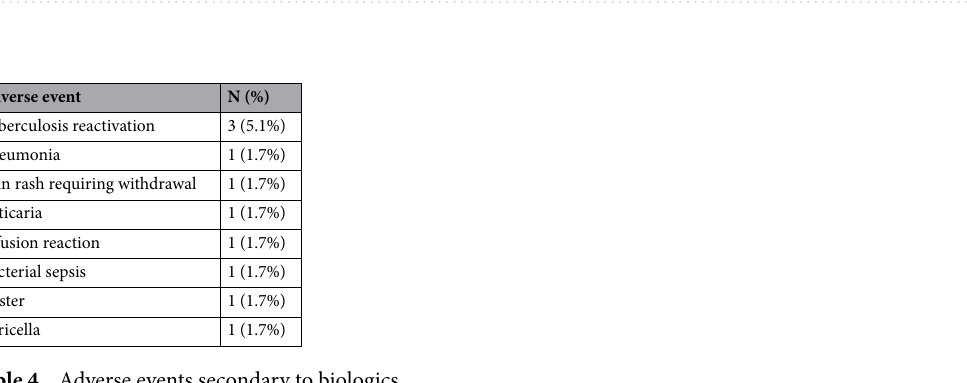
Table 3. Factors predicting anti-TNF failure in stricturing Crohn’s disease.